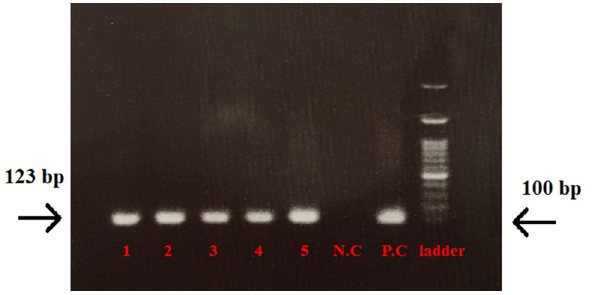
Figure 2. Agarose gel electrophoresis of the PCR product of B16F10 tumor. Purification of amplified IDO fragment. Lanes 1 to 5: B16F10 tumor samples, NC blank control without template (negative control), PC 4T1